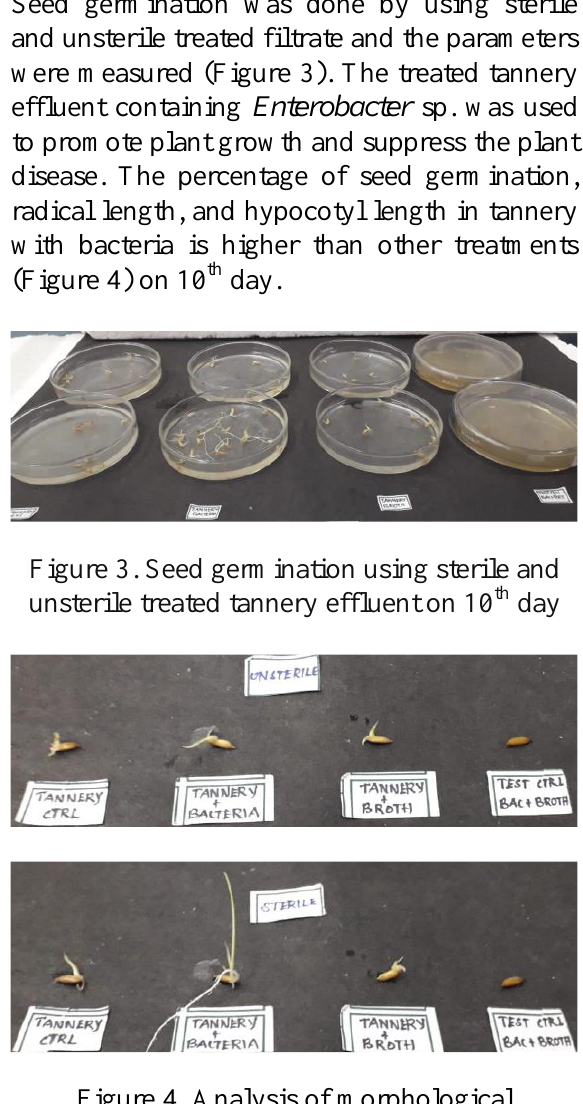
Figure 4. Analysis of morphological parameters on Oryza sativa